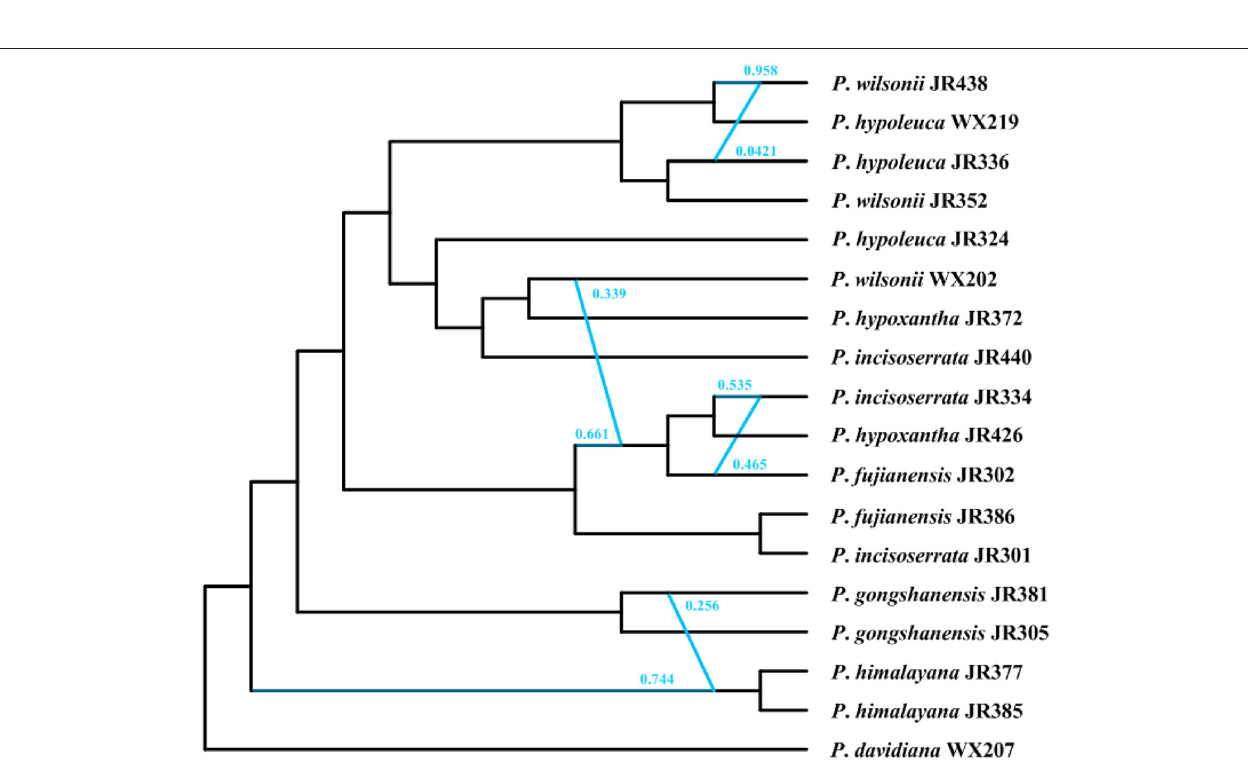
Frontiers in Plant Science |